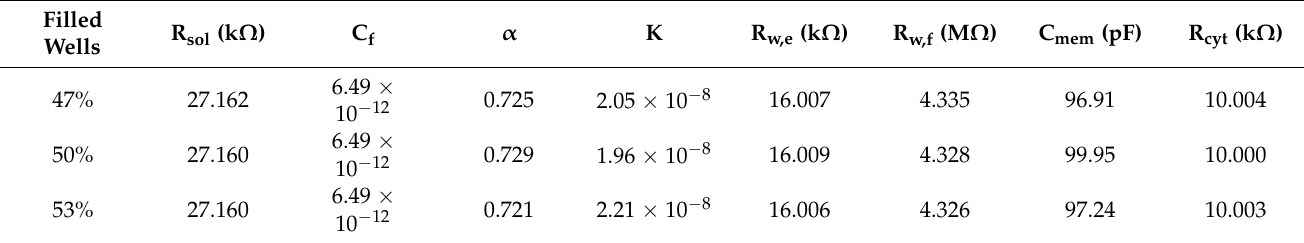
Table 3. Effects of the standard deviation of filled well ratio on the extracted parameters.